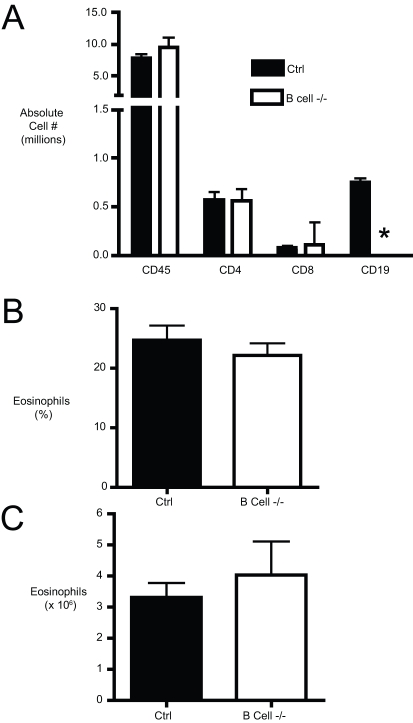
Lung leukocyte and lymphocyte recruitment to the lungs of chronic allergen challenged mice.(A) B cell −/− and control mice were chronically challenged with allergen. The numbers of CD45+, CD4+, CD8+, and CD19+ cells in the lung parenchyma were determined via flow cytometry of enzymatic digests of whole lungs. * = p<0.05 vs. control allergic mice. (B and C) Lung eosinophilia in the lungs of chronic allergen challenged mice. The frequency (B) and absolute number (C) of eosinophils in control and B cell −/− mice were determined from cytospins of enzymatically digested lungs. Bars represent the mean of 5 mice per group ±SEM. Similar results were obtained in three independent experiments.